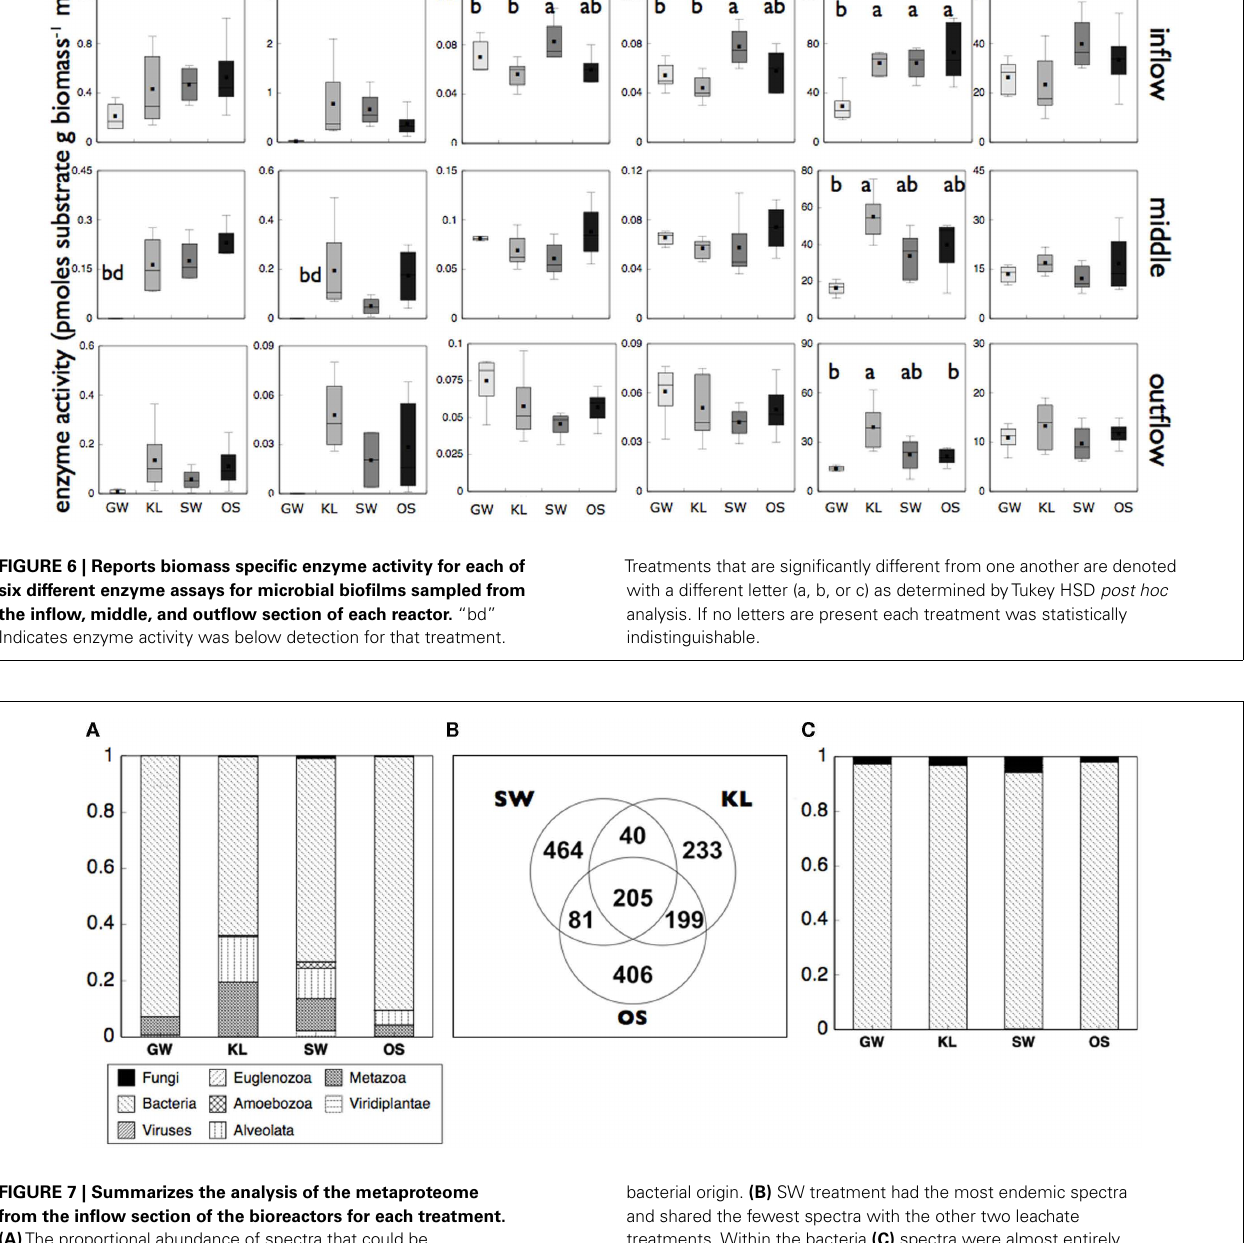
FIGURE 7 | Summarizes the analysis of the metaproteome from the inflow section of the bioreactors for each treatment. (A) The proportional abundance of spectra that could be designated to a phylogenetic origin are dominated by spectra of